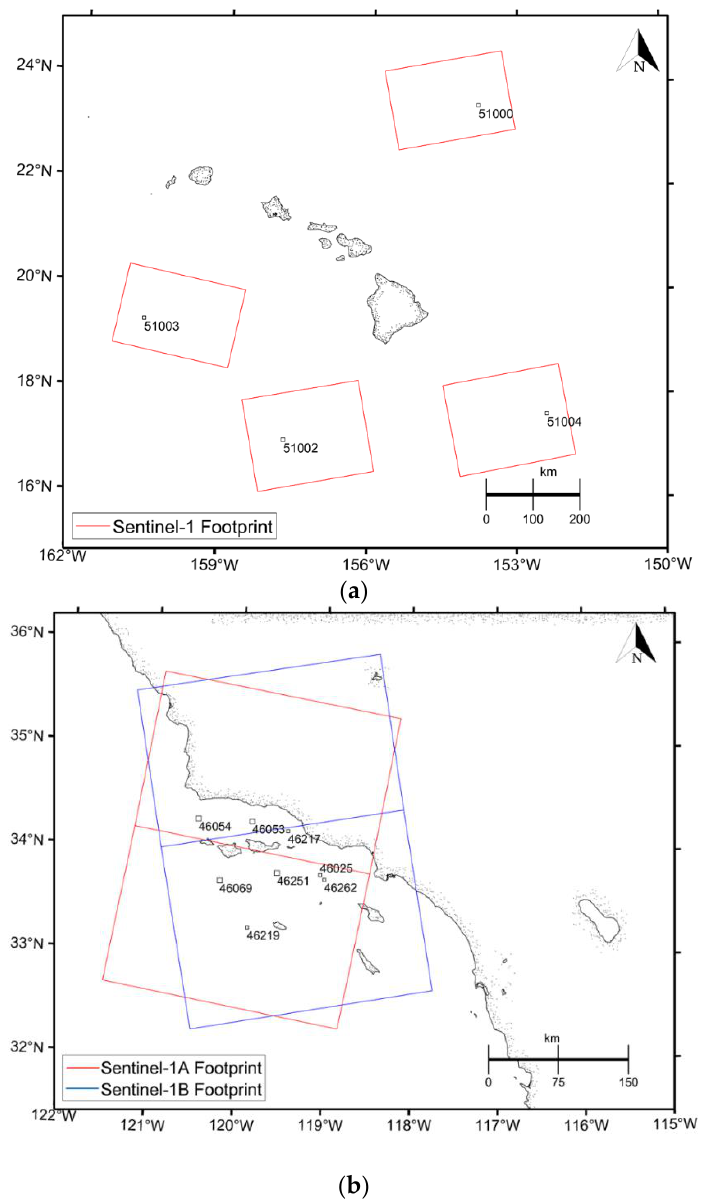
Figure 1. Regions of interest with Sentinel-1 synthetic aperture radar (SAR) image footprints overlaid as colored boxes in the waters near Hawai’i ( a ) and near the Channel Islands on the West Coast of the USA ( b ).